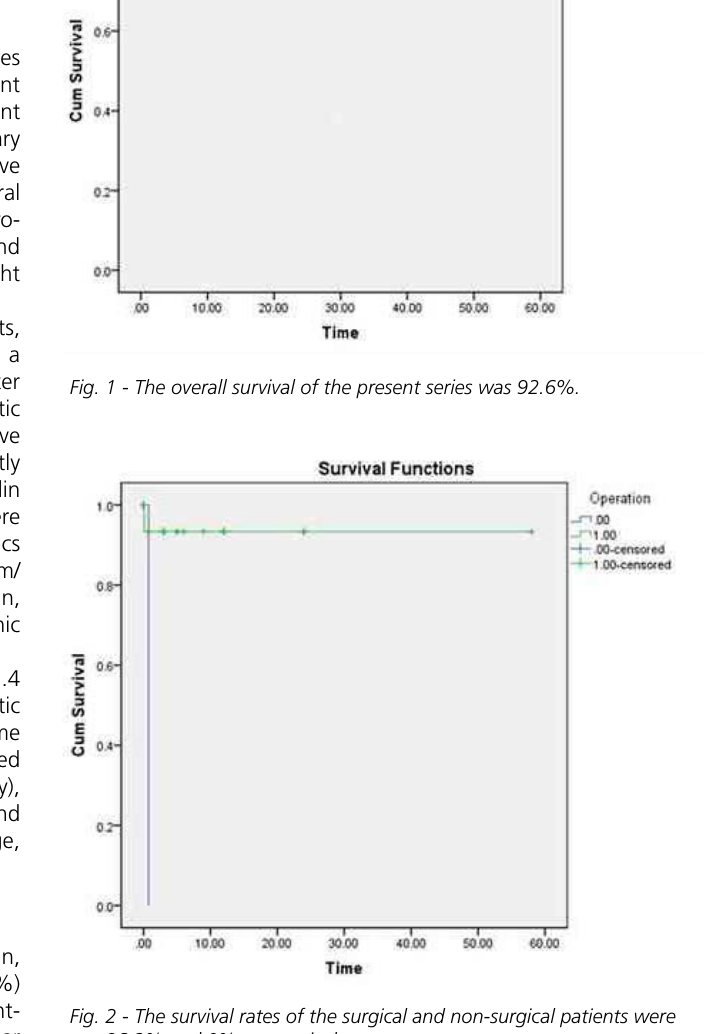
Fig. 2 - The survival rates of the surgical and non-surgical patients were 96.2% and 0%,